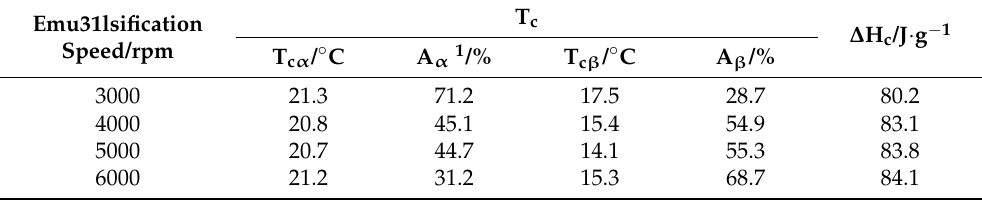
Table 1. The crystallinity properties of the prepared MicroPCMs at different emulsification speeds.